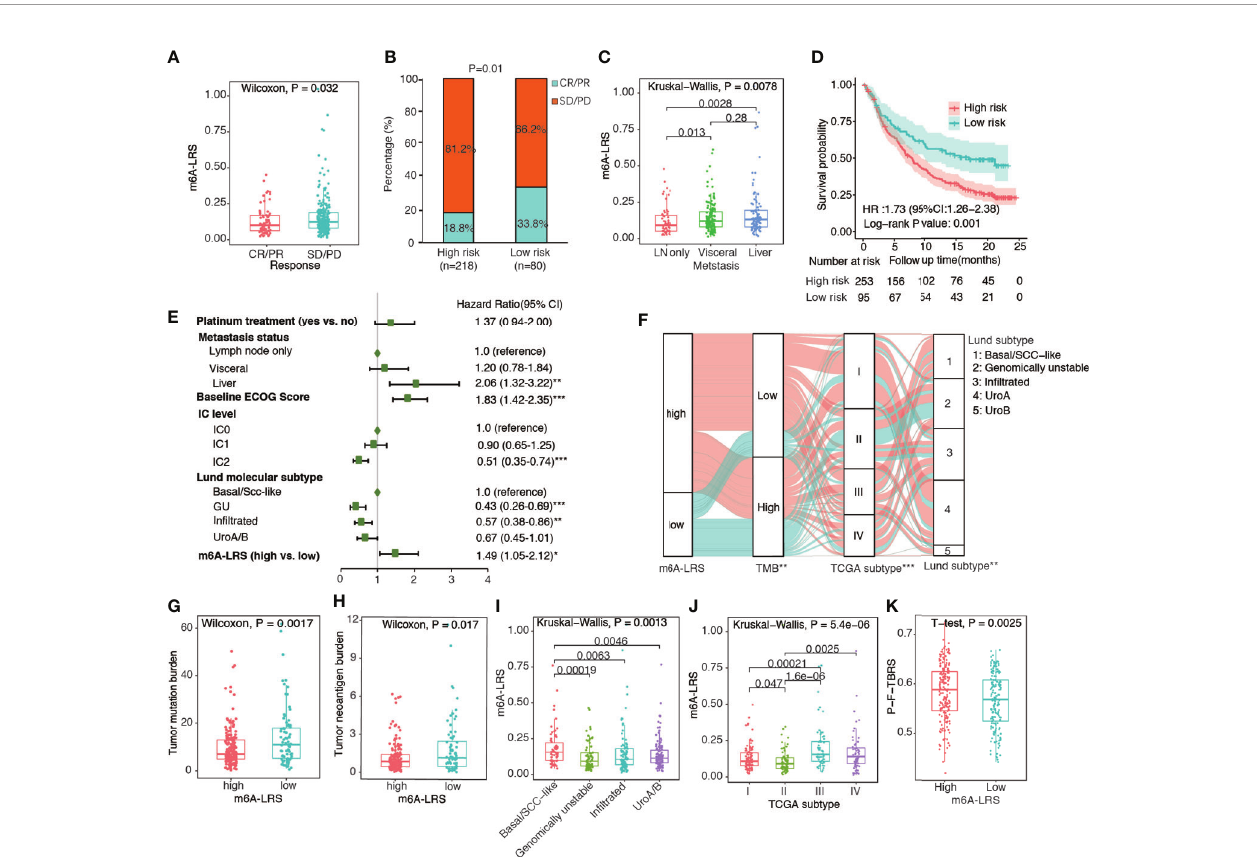
FIGURE 3 | Validation of the m6A-related lncRNA risk score in the IMvigor210 cohort. (A) Distribution of m6A-related lncRNA risk score (m6A-LRS) by response status. CR, complete response; PR, partial response; SD, stable disease; PD, progressive disease. (B) Comparison of response rates between the high- and low- risk subgroups. (C) Distribution of m6A-LRS by metastasis status; (D) Kaplan – Meier curves reveal worse overall survival in the high-risk than the low-risk subgroup. (E) Forest plot of the multivariate Cox regression results showing the independent predictive value of m6A-LRS after controlling for other confounders. Only variables with a p-value<0.05 in the univariate Cox regression were included in the multivariate model. IC: percentage of PD-L1-positive immune cells (IC) stained under immunohistochemically staining: IC0 (<1%), IC1 ( ≥ 1% but <5%), and IC2/3 ( ≥ 5%). *P < 0.05, **P < 0.01, ***P < 0.001. (F) Alluvial diagram showing the changes in m6A-LRS, FMone tumor mutation burden (TMB), TCGA molecular subtype, and Lund molecular subtype in the IMvigor210 dataset. *P < 0.05, **P < 0.01, ***P < 0.001 for chi-square test between m6A-LRS subgroups and the corresponding variables. (G, H) Comparison of TMB and tumor neoantigen burden (TNB) between the high- and low-m6A-LRS subgroups. (I, J) Distribution of m6A-LRS based on TCGA molecular subtypes and Lund molecular subtypes. (K) Comparison of pan- fi broblast-TGF- b response signature score (pan-F-TBRS) between the high- and low-risk